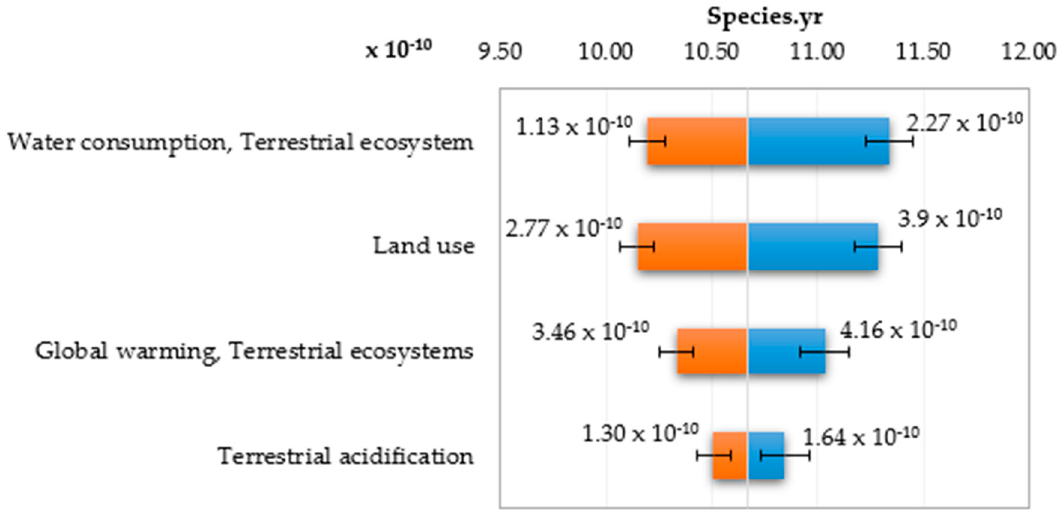
Figure 19. Shares of impact categories in the variance of the total impact of the bottle moulding process in the ecosystem quality area.